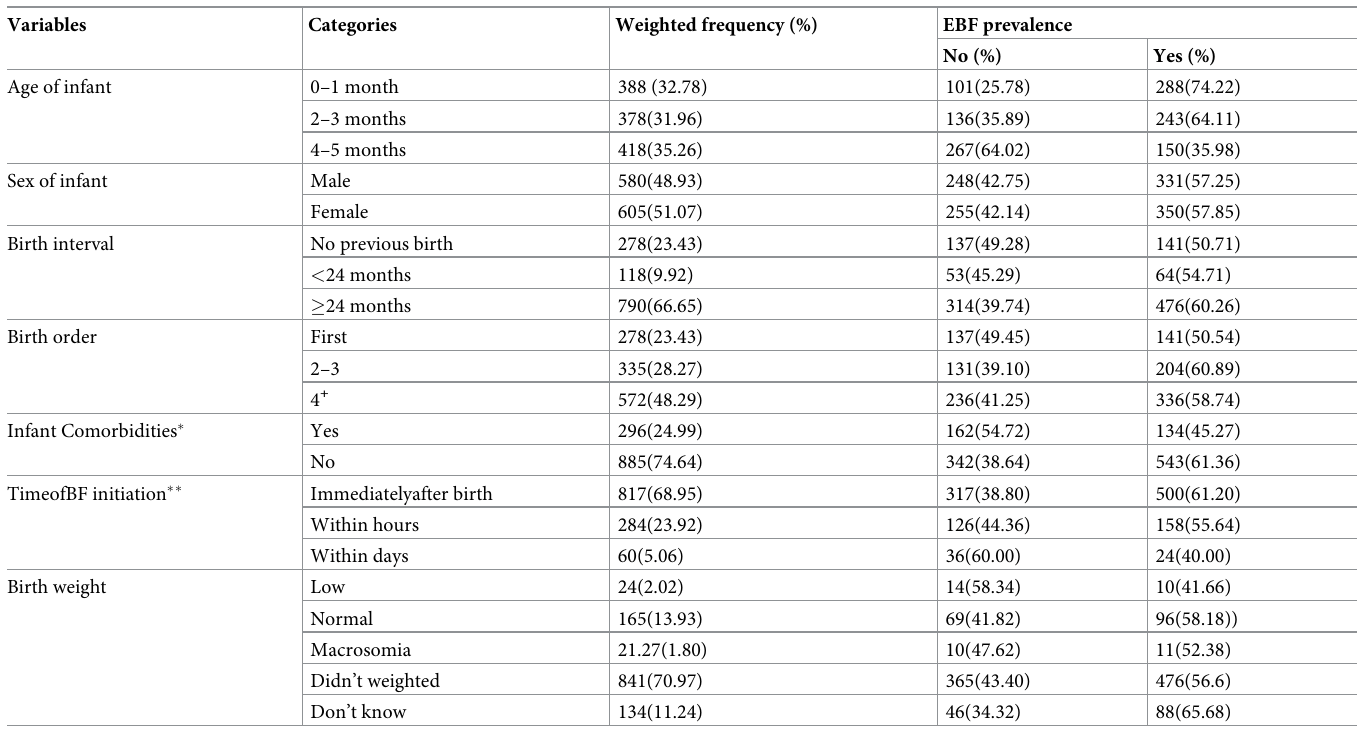
Table 1. Characteristics of infants under six months of age in Ethiopia, 2016 (N =